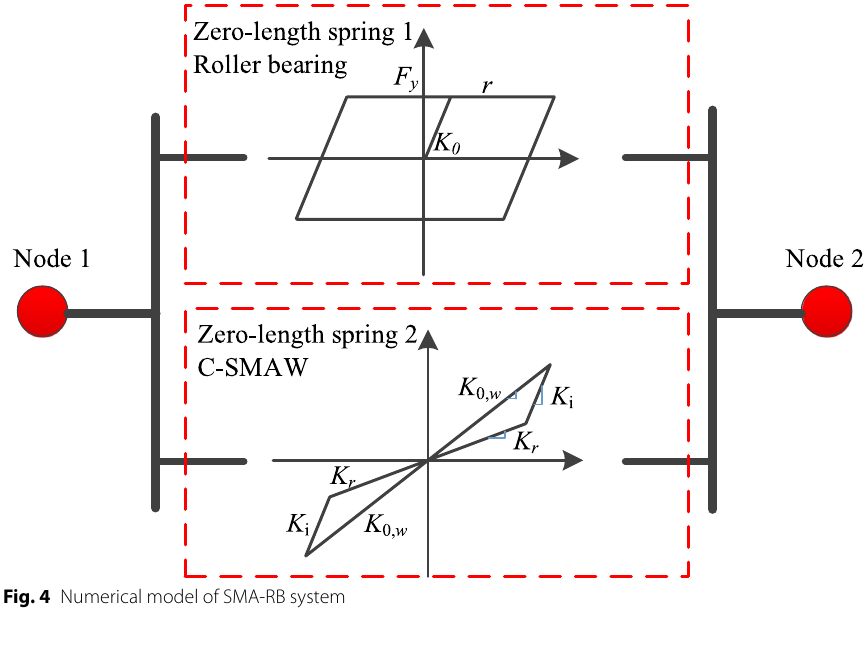
Fig. 4 Numerical model of SMA-RB system